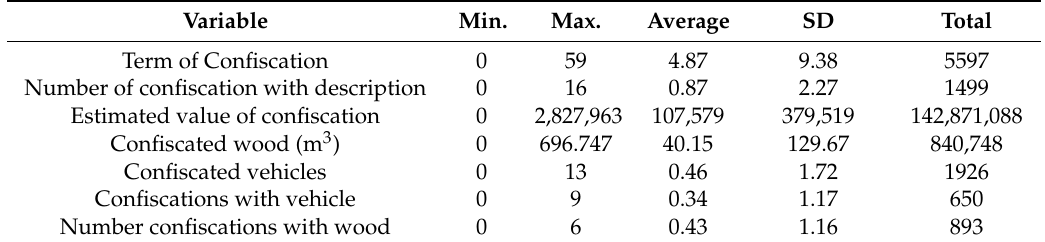
Table 4. Summary statistics for confiscation in study area in Mato Grosso. Variable Min.